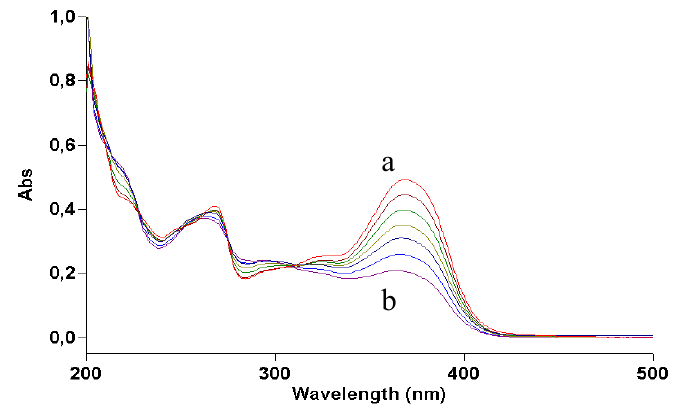
Figure 5. UV absorption spectra of a 2 × 10 − 5 M methanol solution of kaempferol irradiated with increasing doses of UVA. Curve a, dark; curve b, 70 J/cm 2 .